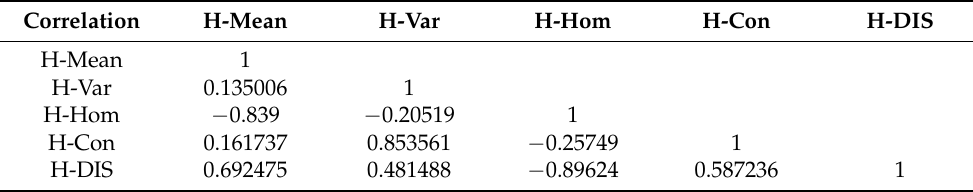
Table 4. Correlation coefficients between